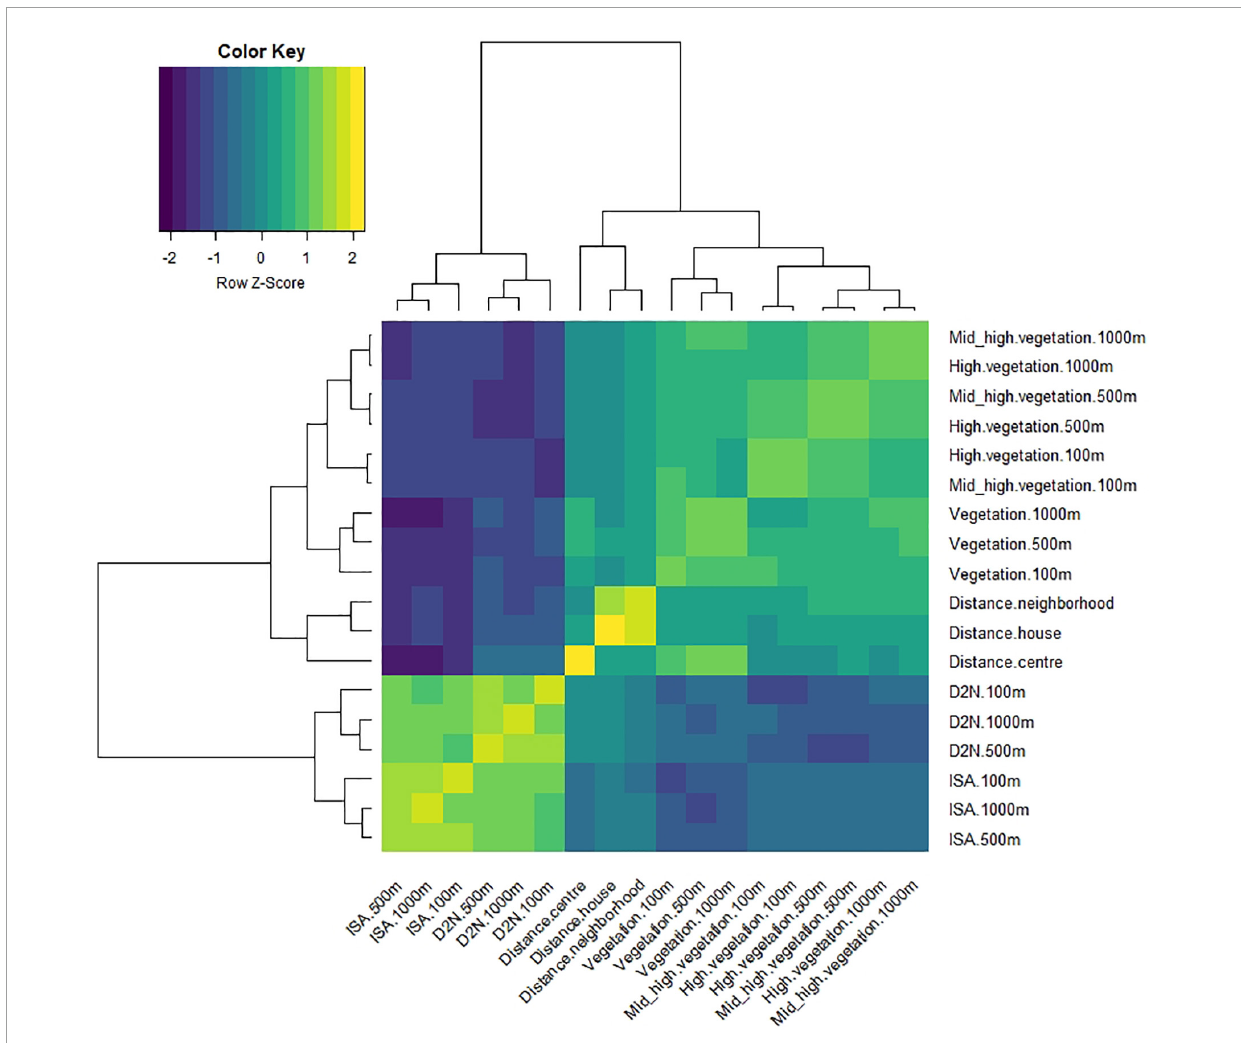
FIGURE2 Heatmap of the correlations between each pair of environmental variables. Positive and negative correlations are in yellow and blue, respectively. The strength of the correlations is reflected by the intensity of the yellow or blue colouration. The dendrogram shows how the variables are clustered. The heatmap was created with the “heatmap.2” function from “gplots” in R software (version 4.1.2) (Warnes et al.,